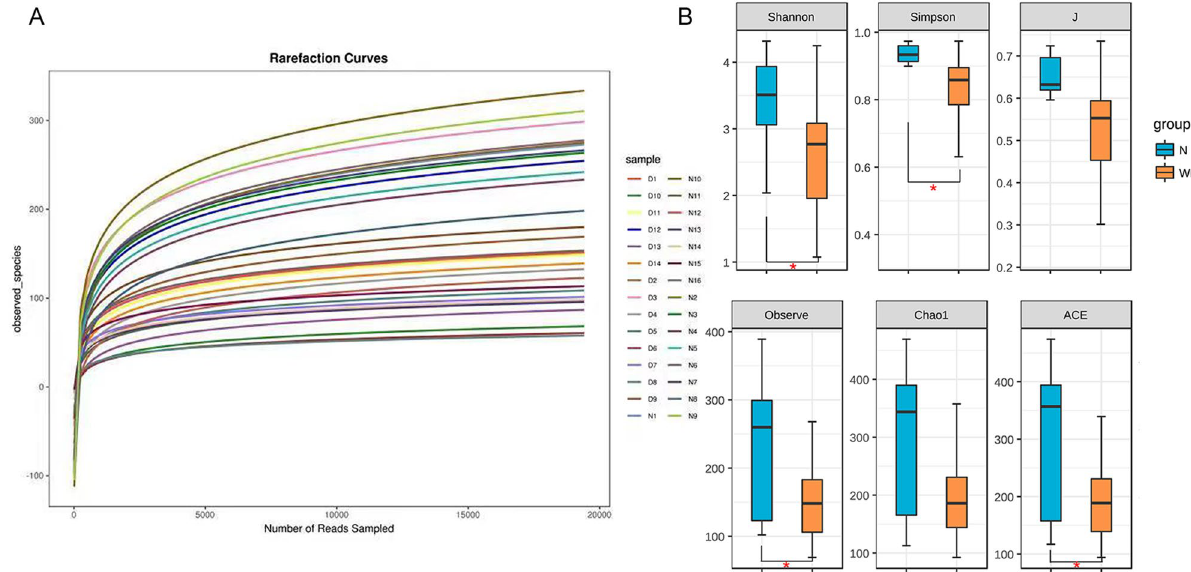
Figure. 4. ( A ) The rarefaction curve was in a flat shape presenting reasonable quantity of the samples. ( B ) Comparison of the alpha diversity of the gut microbiota between the two groups, including species richness (represented by Chao1, Observed species (Observe), ACE and J) and evenness (represented by Shannon and Simpson index). The microbial community of the WD group had less diversity, richness and evenness than the control group. Starred samples (*) showed significant differences between the two